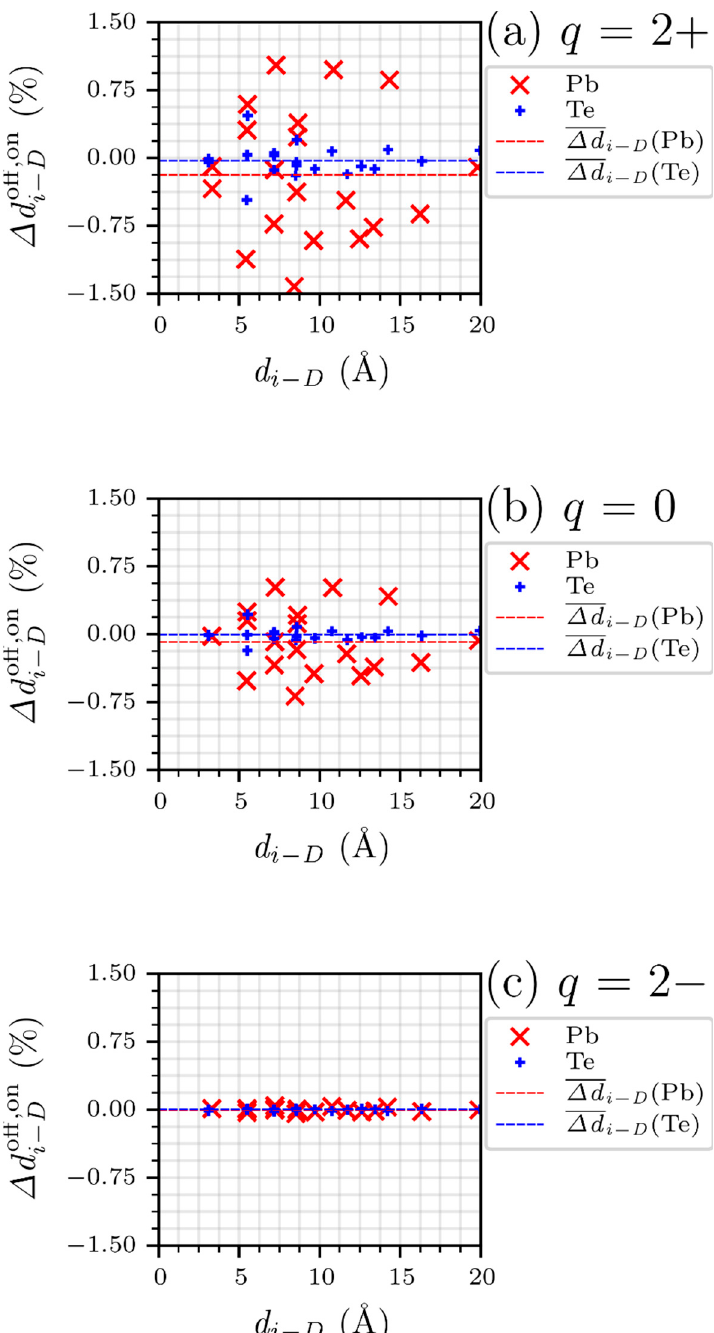
Figure 6. Structure-contrast parameter ∆ d off,on of Pb (red × ) and Te (blue +) under the charge state of ( a ) 2+, ( b ) neutral, and ( c ) 2 − . The red and blue dashed lines represent the average of ∆ d off,on for Pb and Te, respectively. The x-axis represents distance parameter d i − D